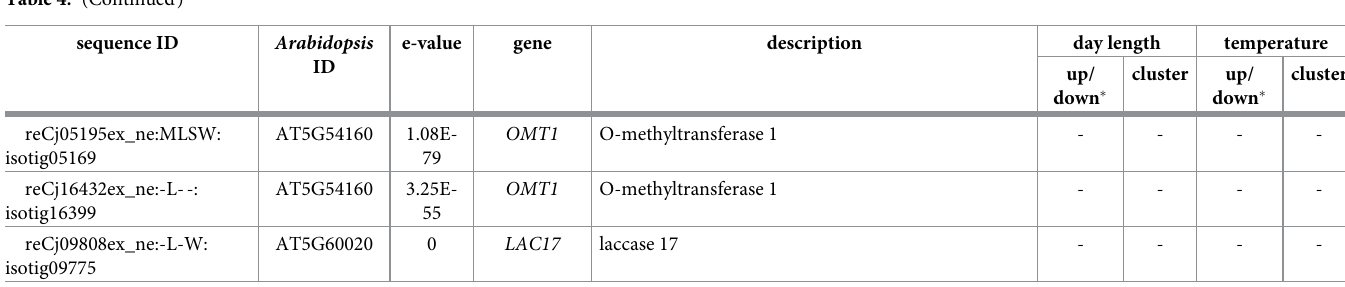
The targets of GO categories ‘pectin catabolic process’, ‘plant-type cell wall modification’, ‘cellulose biosynthetic process’, and ‘lignin biosynthetic process’, which constituted the top 1,000 negative scores for principal component 1, are listed. � Indicates up- or down-regulation under SD (day length) or LT (temperature)